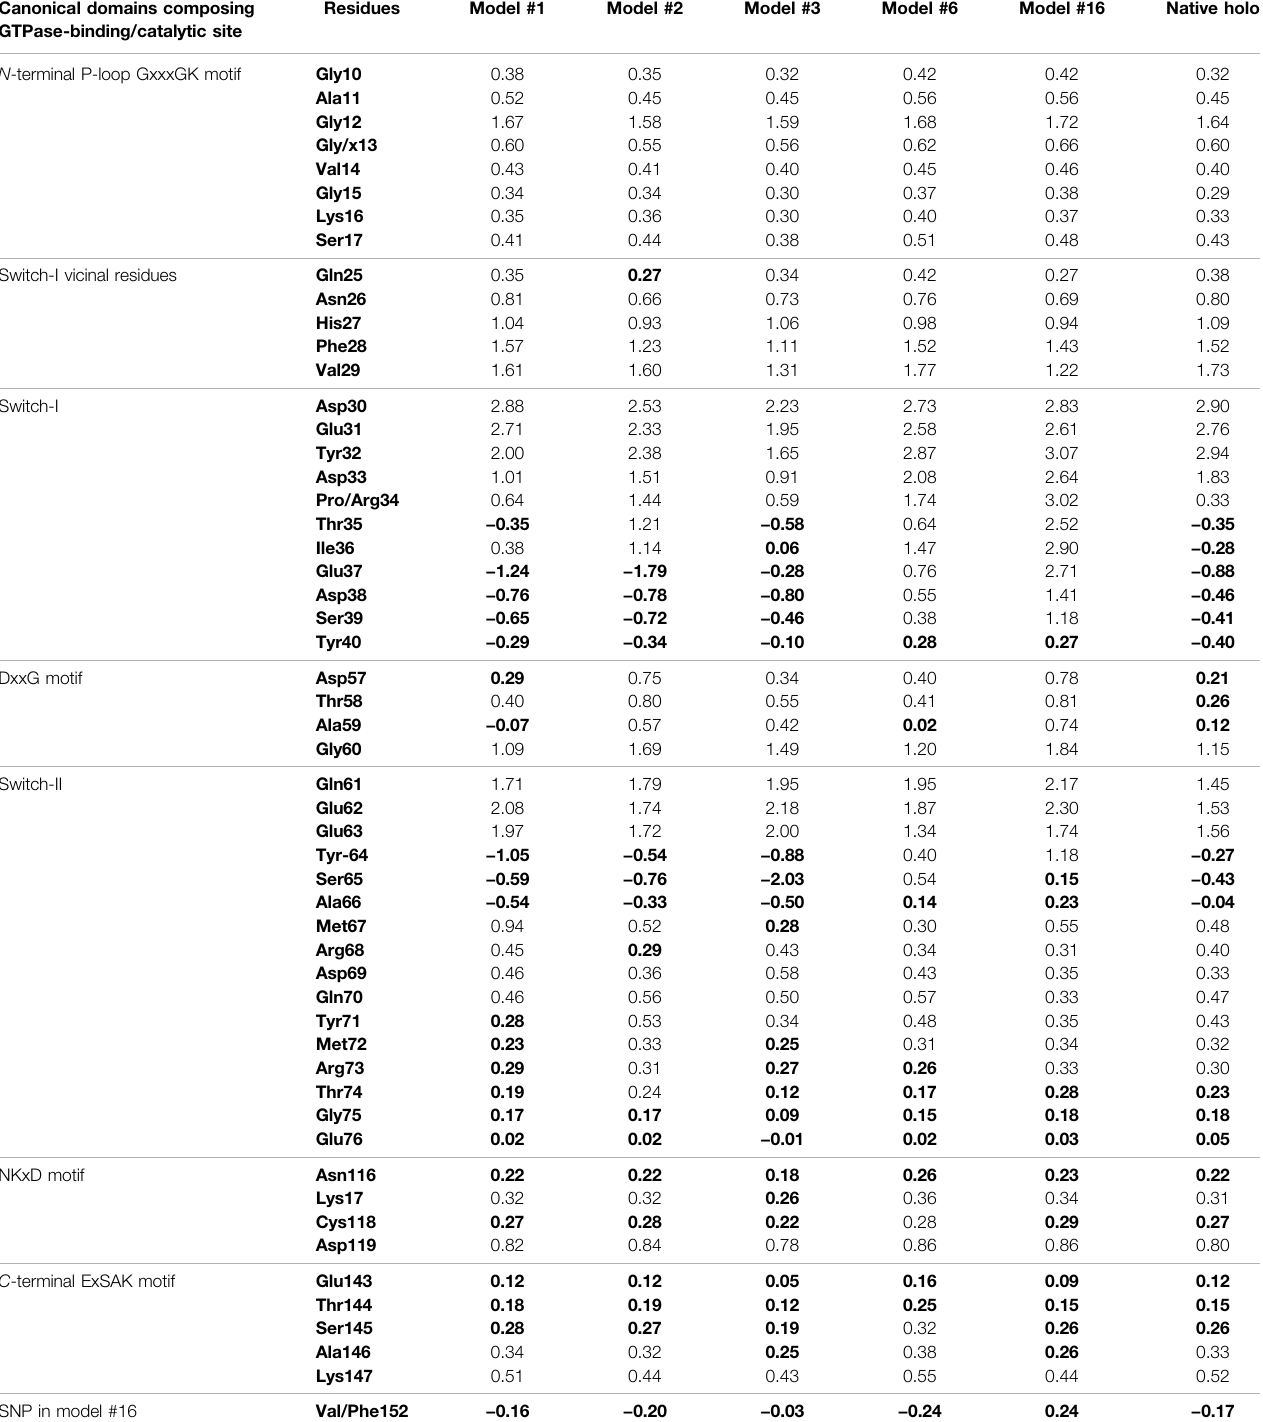
TABLE 5 | Monitored Δ RMSF a [Å] for GTPase NRAS complexes along entire molecular dynamics runs. Canonical domains composing GTPase-binding/catalytic